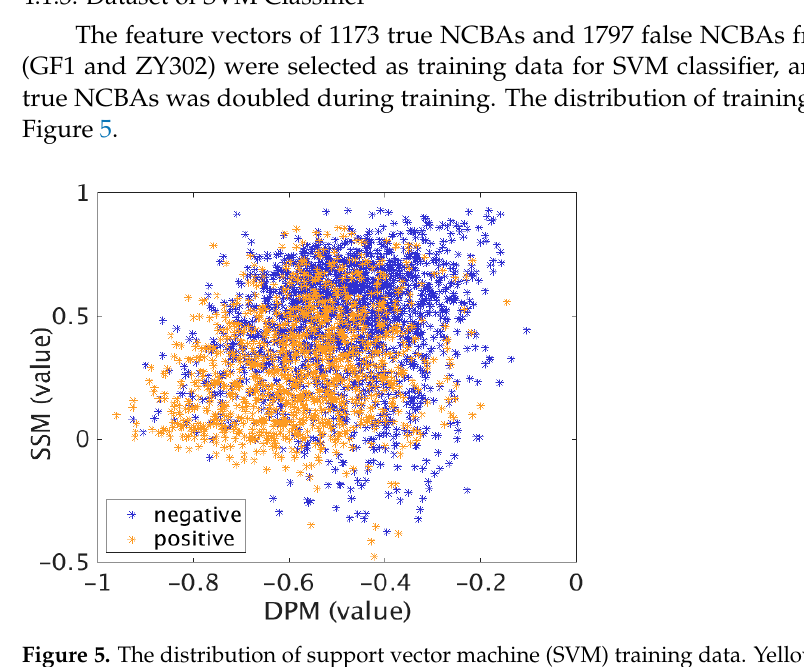
Figure 4. Labeled NCBAs. The areas surrounded by red polygons are marked as NCBAs. T1 and T2 represent pre-temporal and post-temporal images.